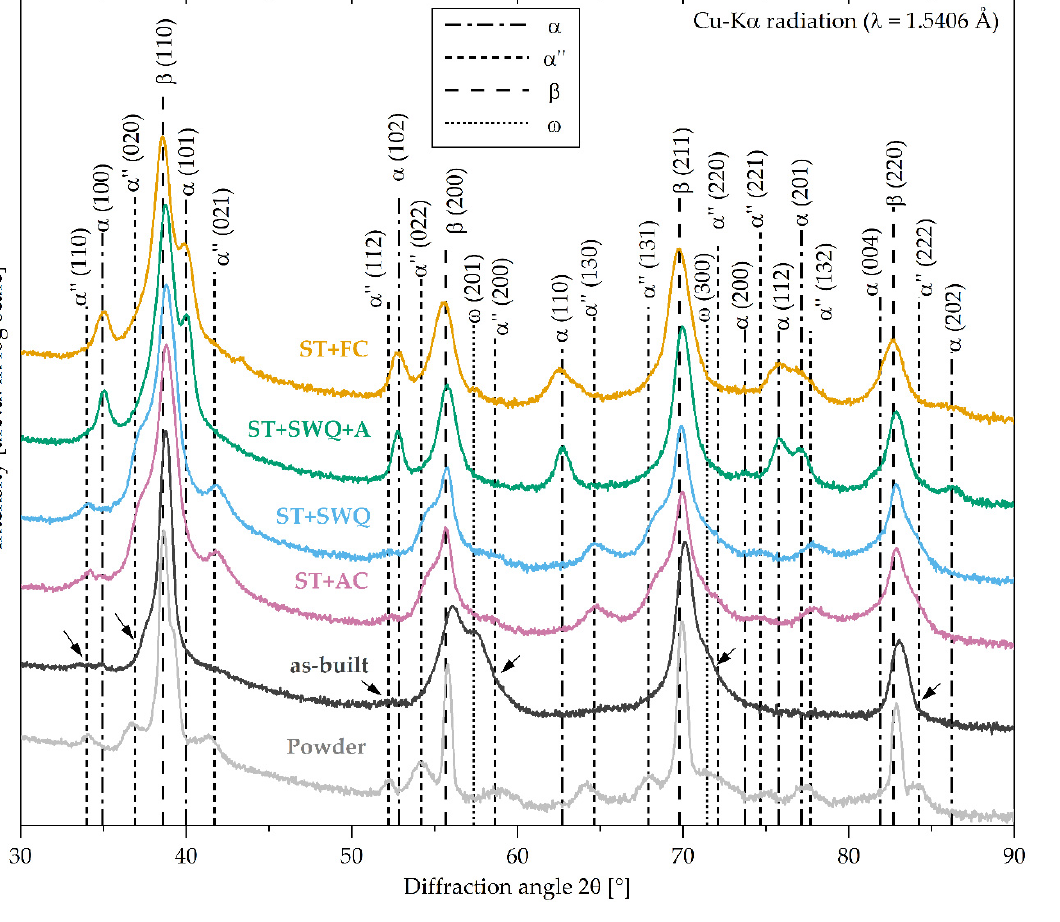
Figure 2. X-ray diffractograms of Ti2448 in as-built, ST+FC, ST+AC, ST+SWQ, and ST+SWQ+A conditions as well as the initial powder; black arrows indicating overlay of α″ phase peaks in the as-built condition; not depicted in the diagram: α″ orthorhombic (111) (superposition with β (110)), α″ orthorhombic (113) (superposition with β (211)); α hexagonal (002) (superposition with β (110)), and α hexagonal (103) (superposition with β (211)).